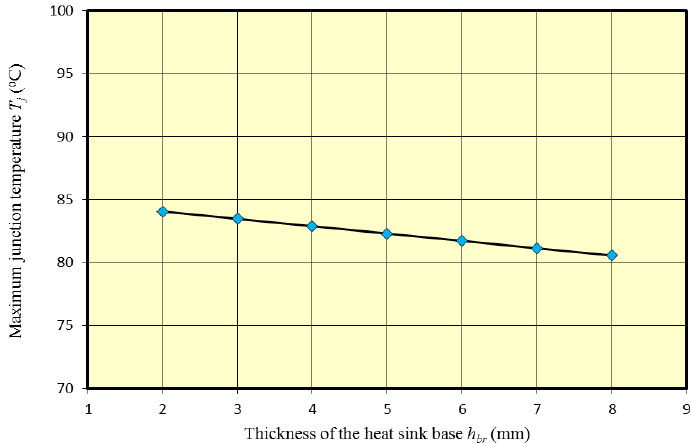
Figure 14. Maximum junction temperature T j of the LED panel installed sources in the function of radiator substrate thickness h br.